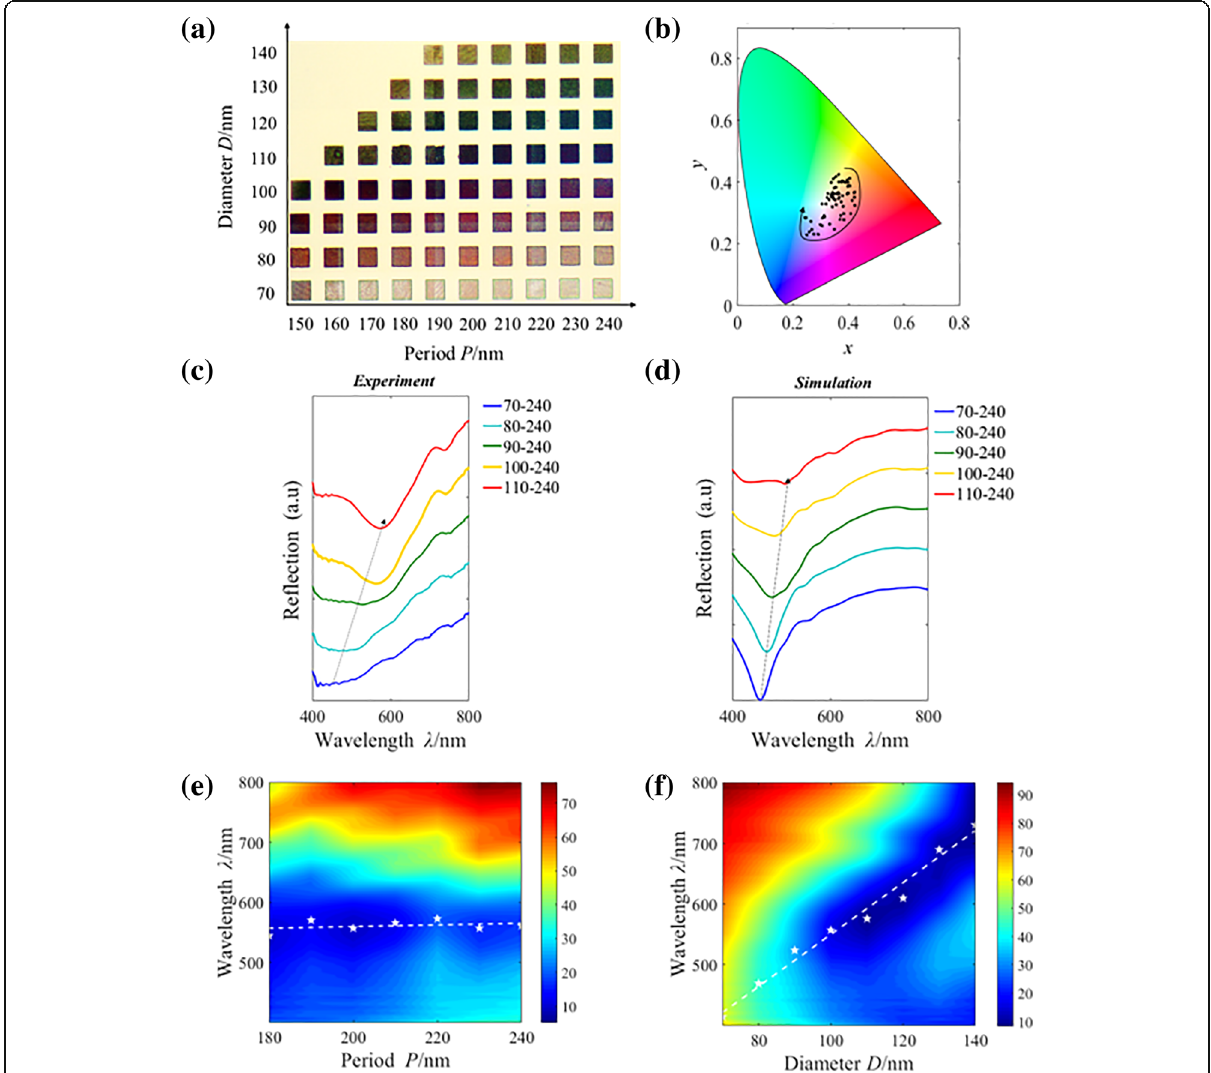
Fig. 2 a Recorded color palette of the reflective subtractive colors as functions of the period P (varying from 150 to 240 nm in an increment of 10 nm) and diameter D (varying from 70 to 140 nm in an increment of 10 nm). Each palette square has a size of 8 × 8 μ m 2 , and the whole array is under illumination by an un-polarized white light. b CIE1931 chromaticity diagram overlaid with the black points corresponding to the colors extracted from a . Experimental ( c ) and simulated ( d ) reflective spectra of the nanostructure arrays with different geometrical parameters. For example, “ 70 – 240 ” means D = 70 nm, P = 240 nm. e Contour map of the experimental reflective spectra as a function of the incident wavelength and period. The period P changes from 180 to 240 nm, while keeping D = 100 nm as a constant. f Experimentally reflection contour map for nanostructure arrays with different diameters changing from 70 to 140 nm at a constant period of 230 nm. The white asterisks represent the valleys ’ positions ( λ min ), and the white dashed lines refer to the fitted straight lines with the corresponding